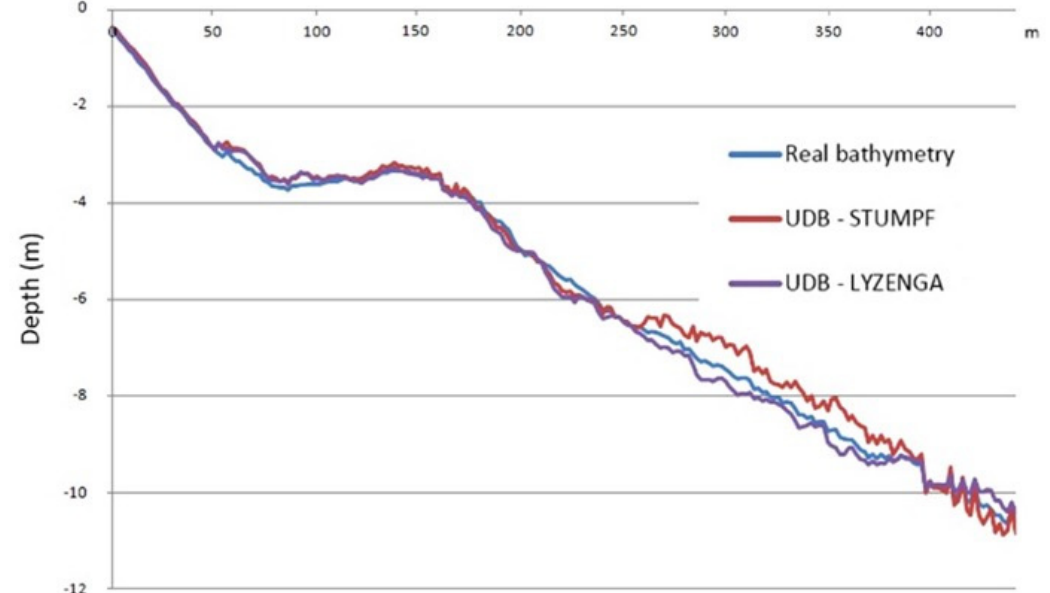
Figure 13. UDB with Lyzenga and Stumpf models and a real surveyed profile located in the center of the study area and perpendicular to the shoreline, as in Figure 4.